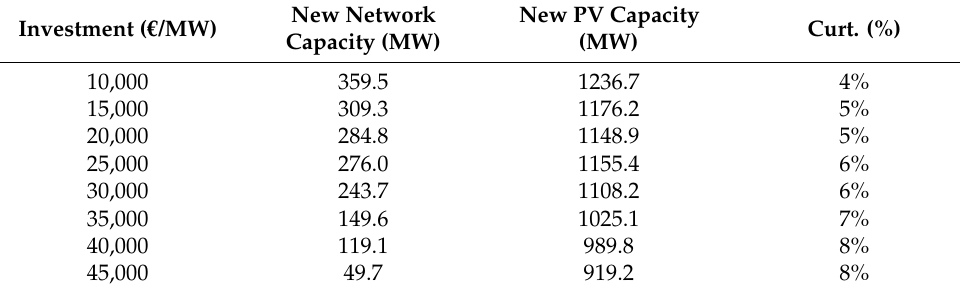
Table 4. Results for the second